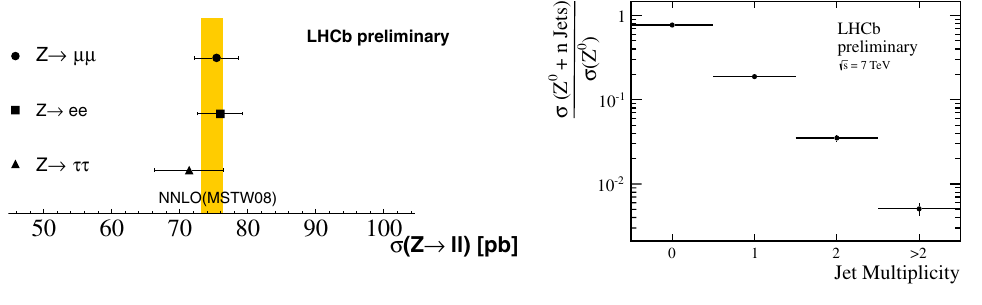
Figure 3. Inclusive Z cross-section measurements compared to theoretical prediction (left) and jet multiplicity distribution in Z → (cid:2)(cid:2) events (right).